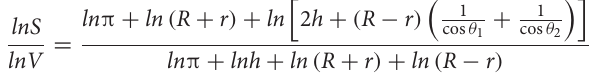
are very approximate ( R -squared: 0.993 and 0.990 for linear and nonlinear regressions).